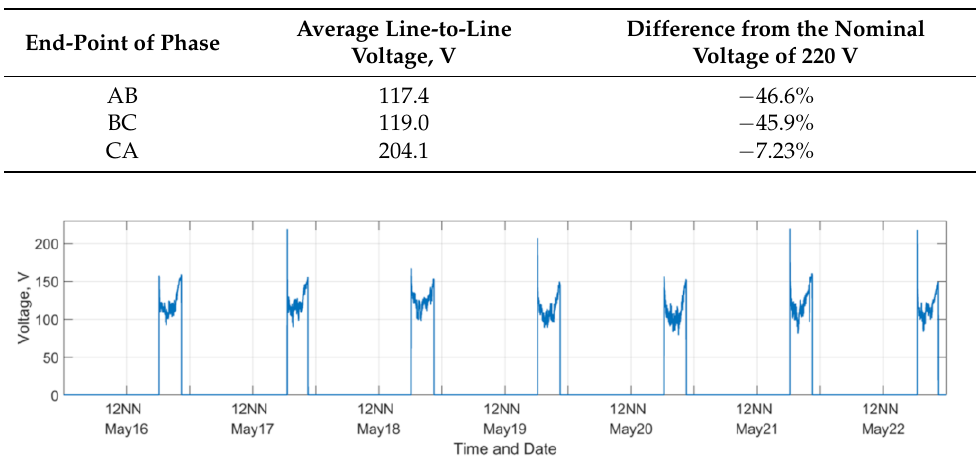
Table 6. Average voltage near the end-points of the phases of the distribution system on Gilutongan Island measured over a one-week period from 16 to 22 May 2019.